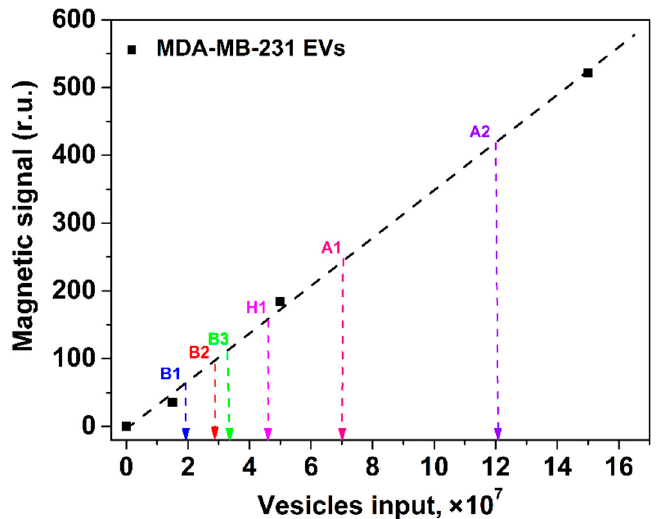
Figure 7. Quantification of EVs isolated from clinical samples with the proposed nanomagnetic IC tool using the calibration plot (shown by the black dashed line) for CD81 + /CD9 + MDA-MB-231 EVs. Clinical samples: serum from patients with breast cancer (B1–B3), a healthy donor (H1), and ascites fluids of patients with ovarian cancer (A1, A2).